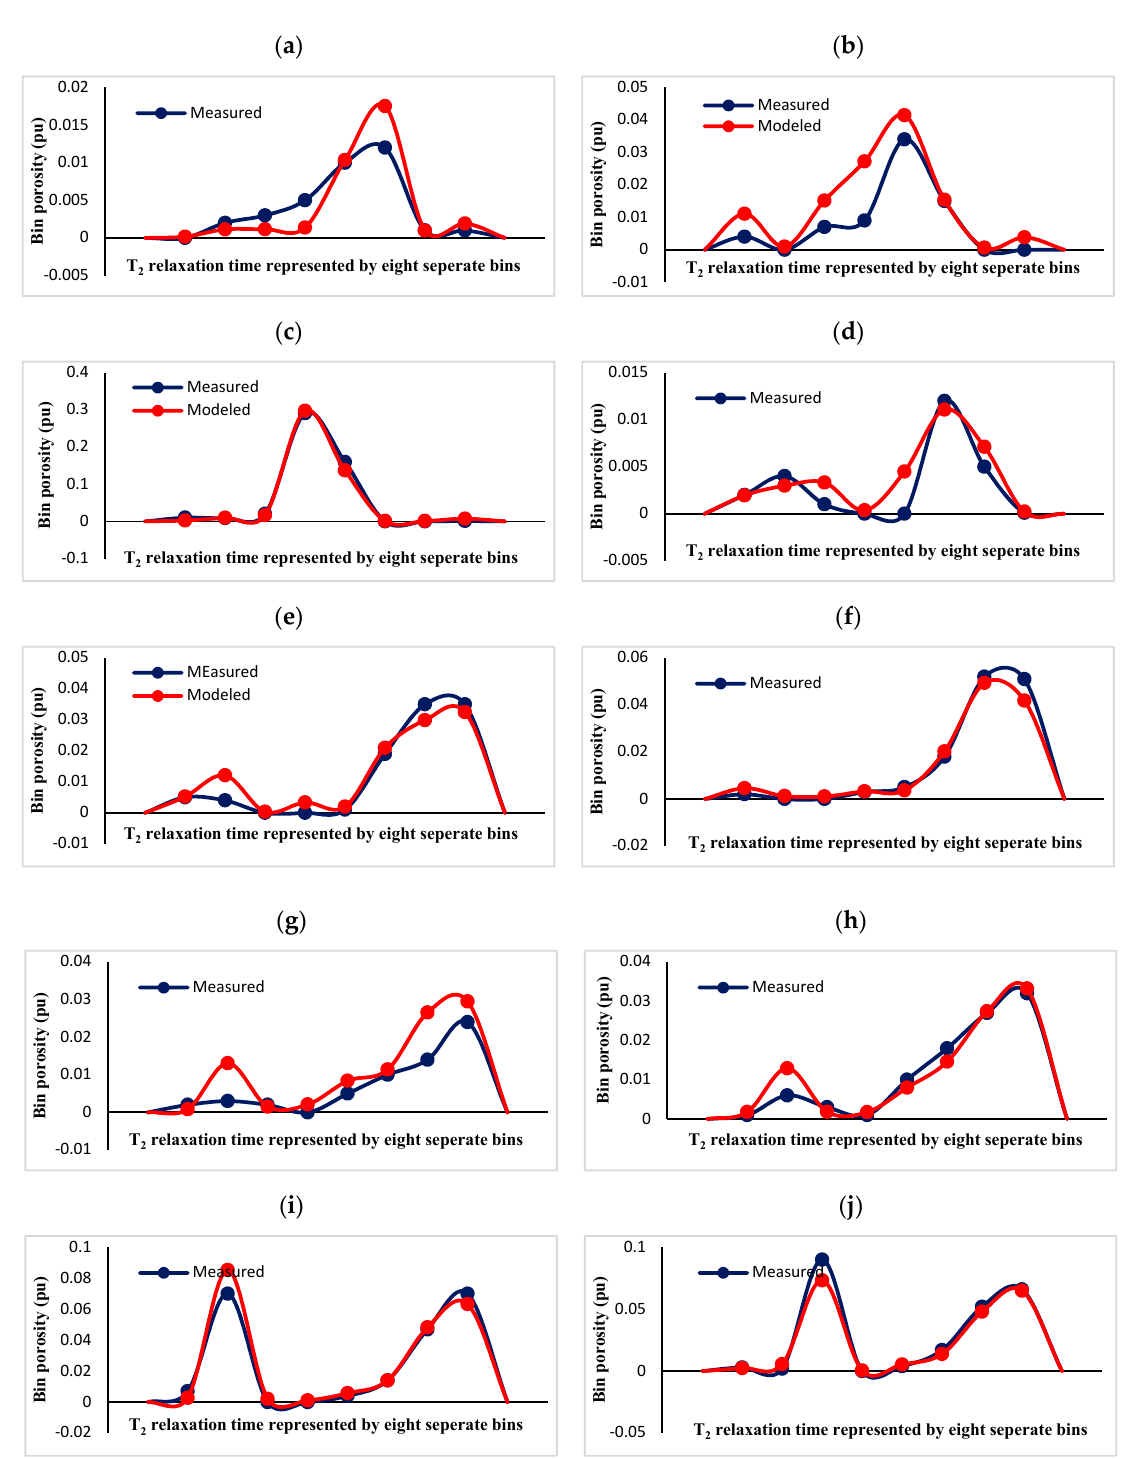
Figure 10. ( a – j ) Measured and predicted T 2 relaxation curves at ten example points of one studied well. Such relaxation curves could be synthesized for every desired part of the reservoir using the established models and the introduced method.